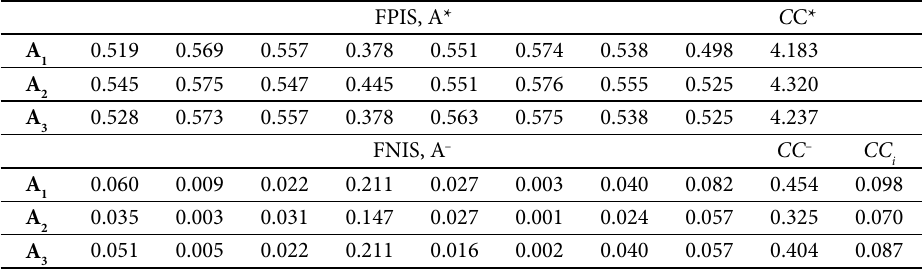
Table 9. Distances of each alternative from fuzzy positive-ideal solution and fuzzy negative-ideal solution FPIS, A* C